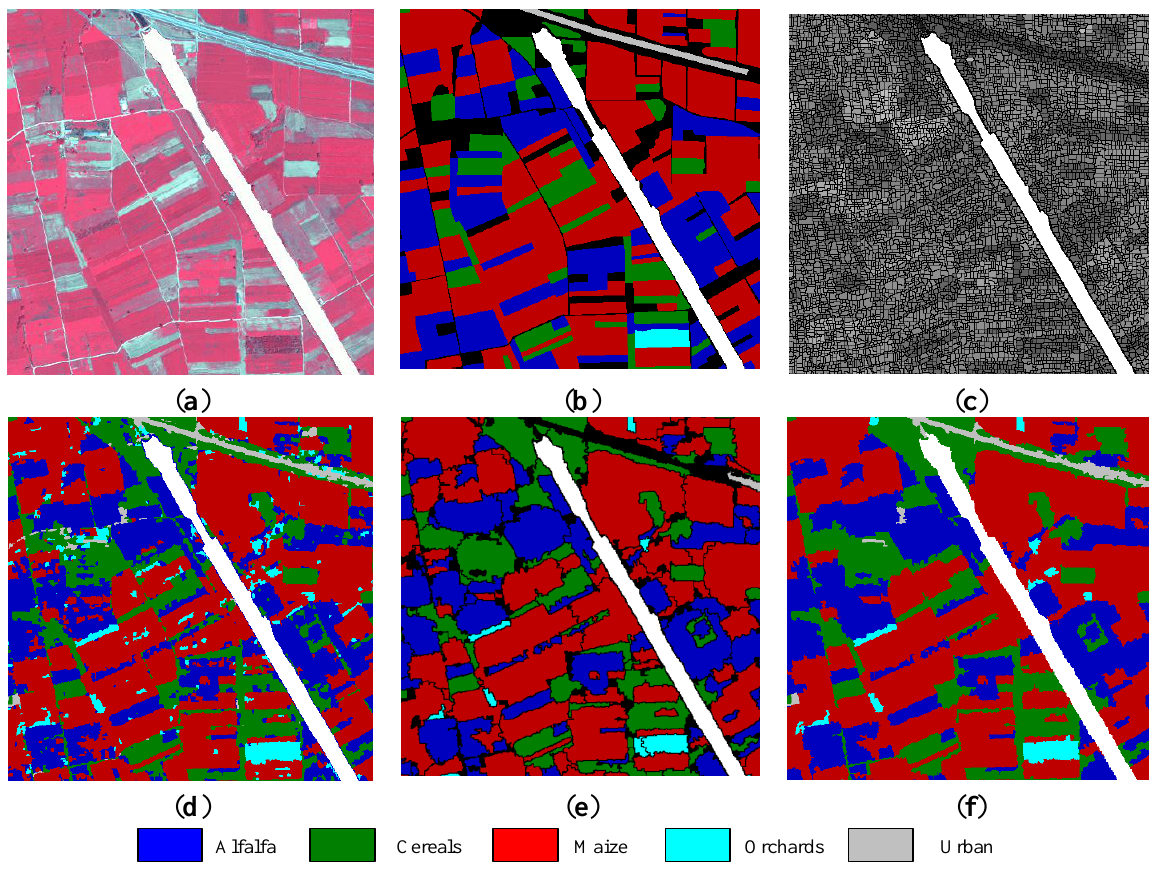
Figure 9. Koronia image: ( a ) three-band false color composite, ( b ) reference sites, ( c ) watershed segmentation map, ( d ) initial segmentation map after CC labeling, ( e ) segmentation map after GeneSIS (black areas denote the yet uncovered regions of the image), and ( f ) classification map after